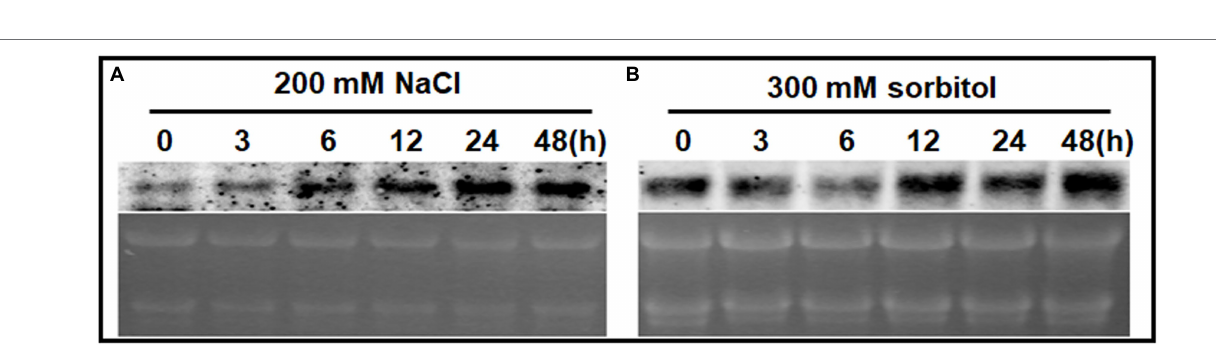
FIGURE 3 | ChPAP2 -overexpressing yeast cells exposed to NaCl and sorbitol stresses. Serial dilutions of yeast cells containing the pYES2 empty vector or pYES2- ChPAP2 were independently spotted into solid yeast (1% yeast extract, 2% peptone, and 2% galactose) medium containing plates supplemented independently with 0.8-M NaCl, 1.0-M NaCl, and 1.6-M sorbitol.